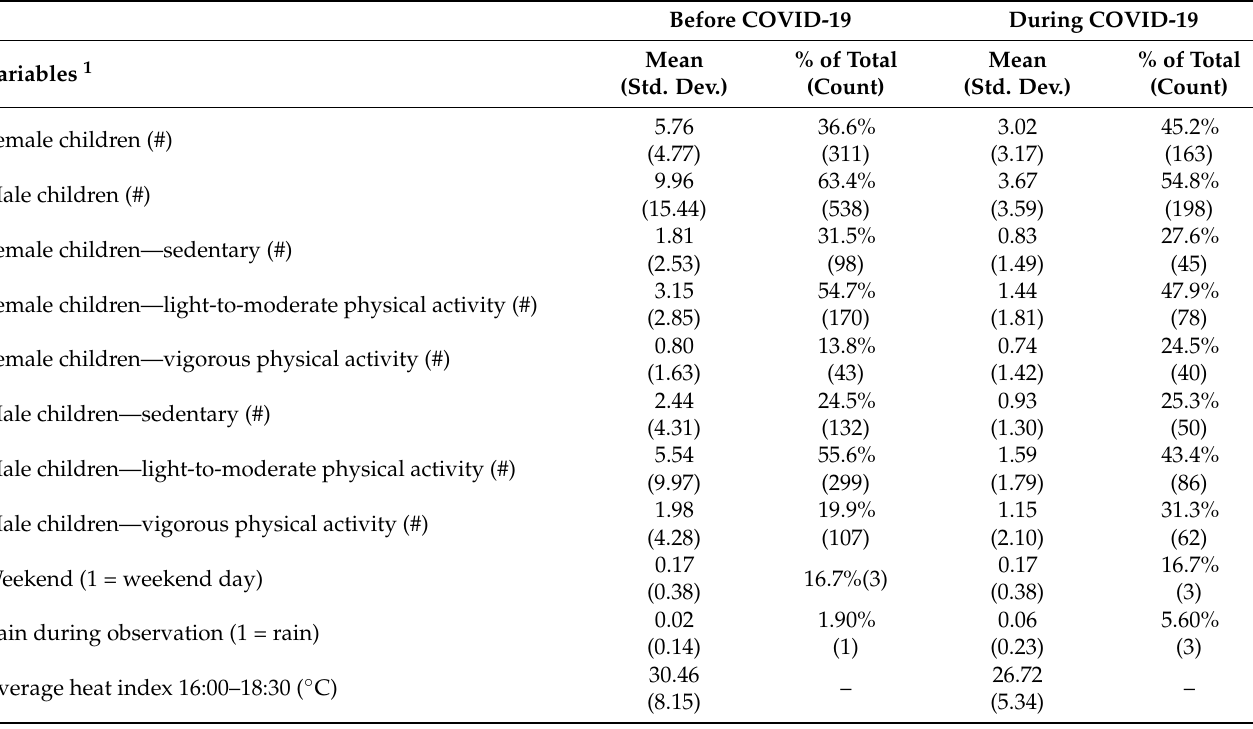
Table 1. Pooled summary statistics for joint-use parks outside of school hours.